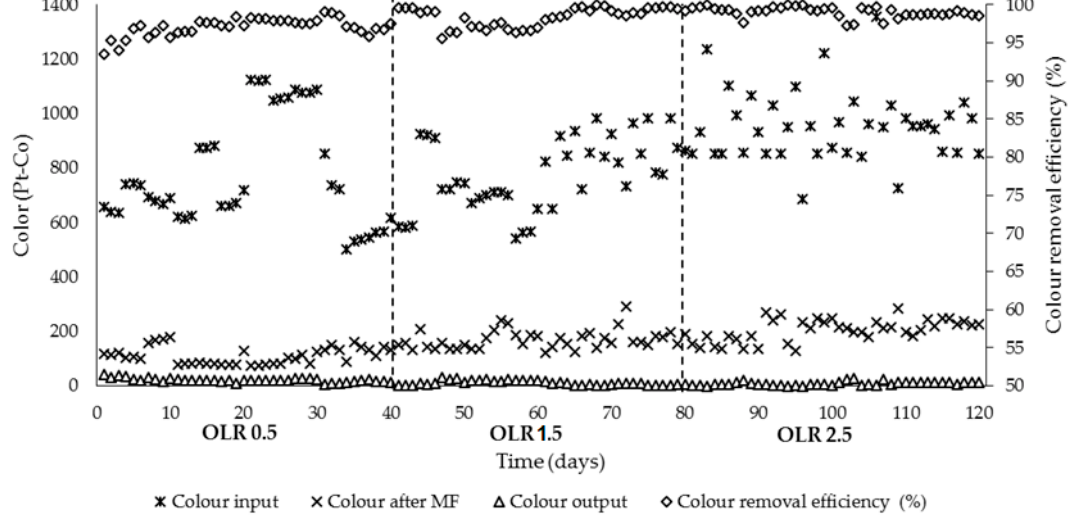
Figure 7. Color removal efficiency at three organic load rates in a duration of 120 days of the MBR-Nano system.